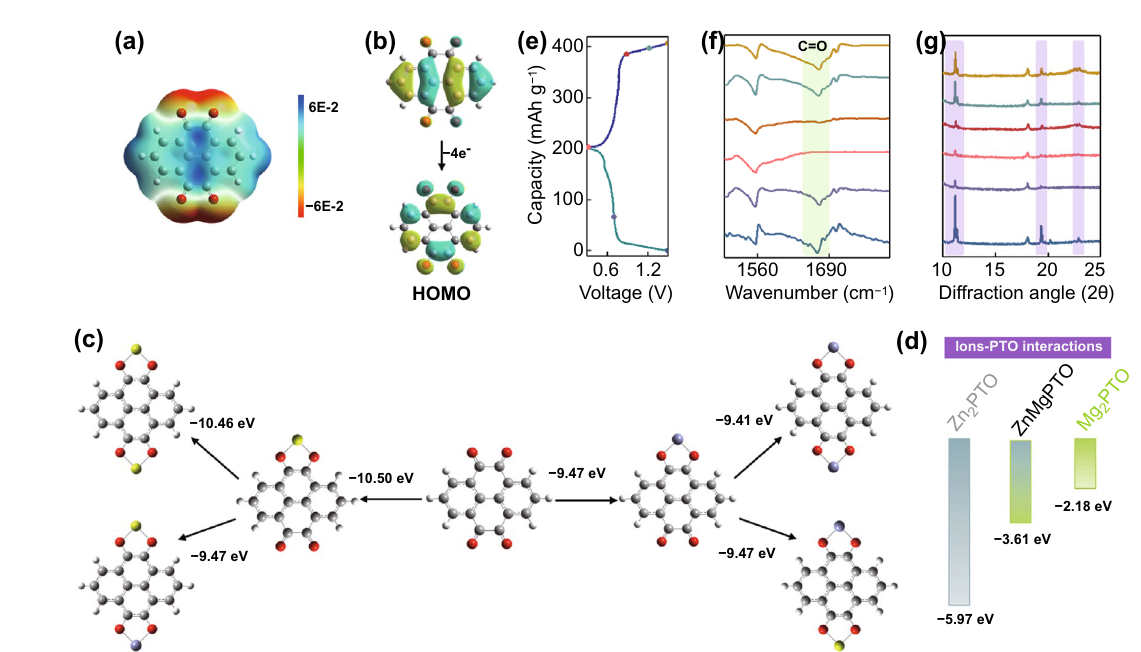
Fig. 3 a ESP of PTO molecule. b HOMO plots of PTO and PTO 4− . c Binding energies between PTO and Zn 2+ or Mg 2+ . d The corrected bind- ing energy levels of Zn 2 PTO, ZnMgPTO, and Mg 2 PTO. e Charge–discharge curves of Zn||PTO battery. f Ex situ FTIR spectra of PTO elec- trodes. g Ex situ XRD patterns of PTO